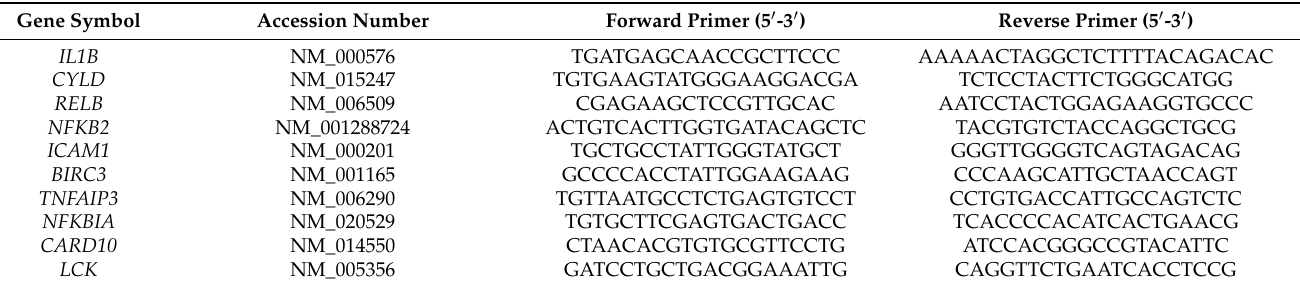
Table 1. Sequences of primers used for real-time PCR.